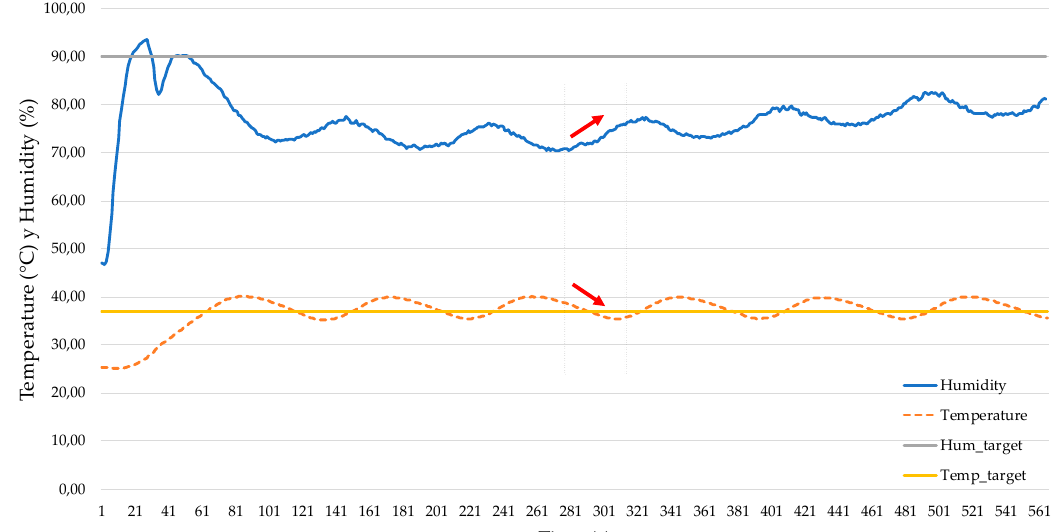
Figure 7. Theoretical and experimental transfer functions simulation without a PID controller.